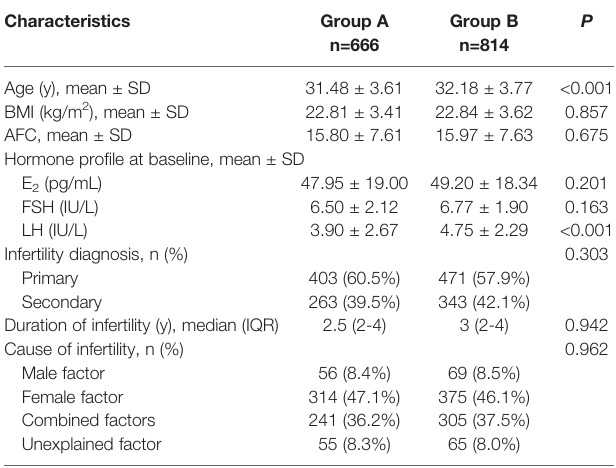
TABLE 1 | Baseline patient characteristics.